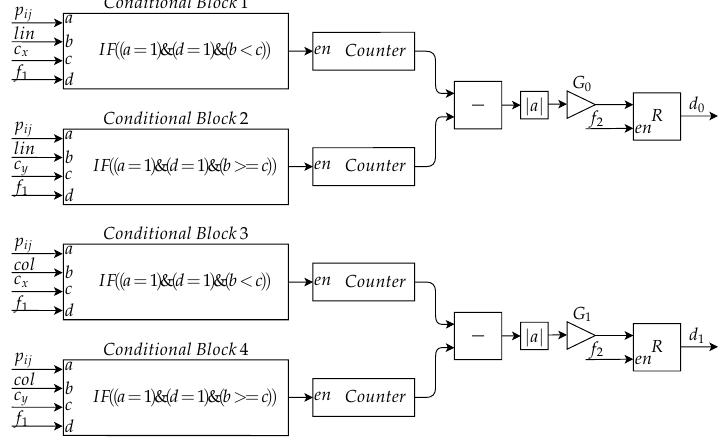
Figure 12. Architecture of the Symmetry Calculation Submodule to determine the symmetry.